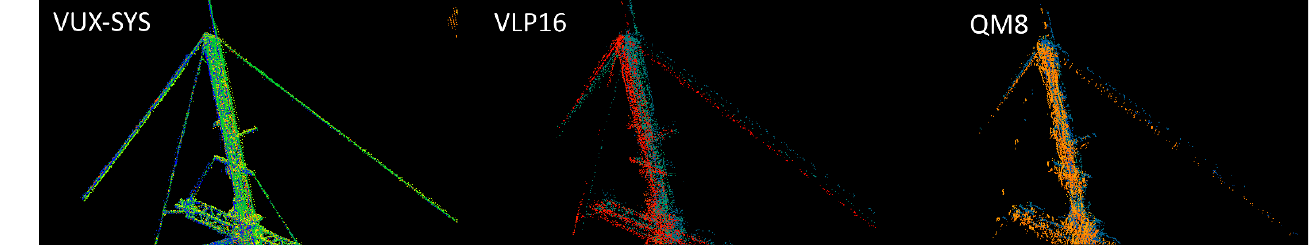
Figure 5. Side views of the top of the flux tower, with the points coloured by GPS time; thus, different passes with the systems are shown in different colours. Co-registration issues between the different flight lines are visible for the VLP16 and QM8 sensors.